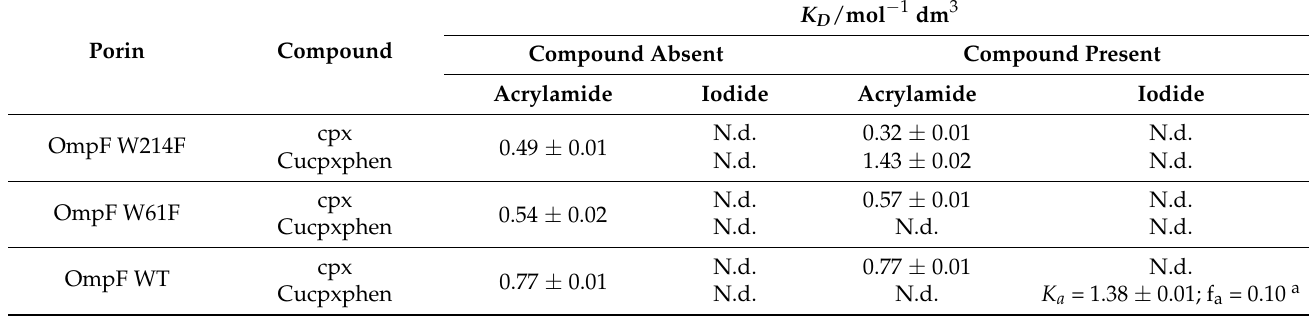
Table 5. Values of the Stern-Volmer constants ( K D and K a ) determined for the quenching of OmpF (WT, W61F and W214F)/E. coli total extract proteoliposomes by iodide and acrylamide, in the absence and in the presence of cpx and Cucpxphen solutions, by steady- state fluorescence, using Equations (6) and (9). The presented values are the mean of, at least, three independent experiments ( ± SD). K D / mol − 1 dm 3 Porin Compound Compound Absent Compound Present Acrylamide Iodide Acrylamide Iodide 0.49 ±